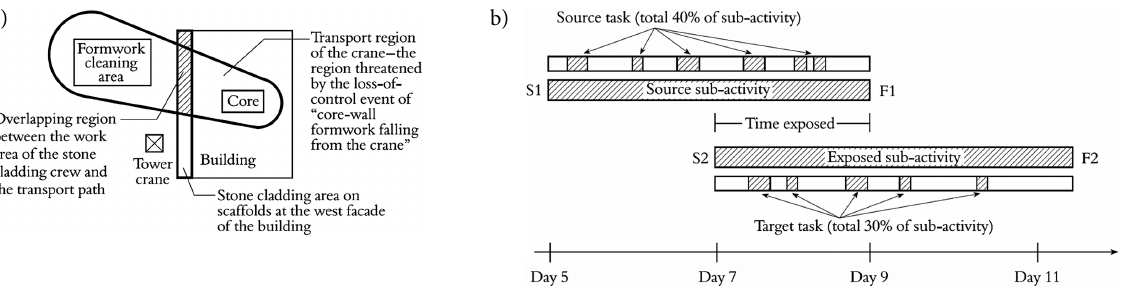
Figure 3. (a) Spatial overlap leading to spatial exposure; (b) Temporal overlap leading to temporal exposure (Rozenfeld et al.,